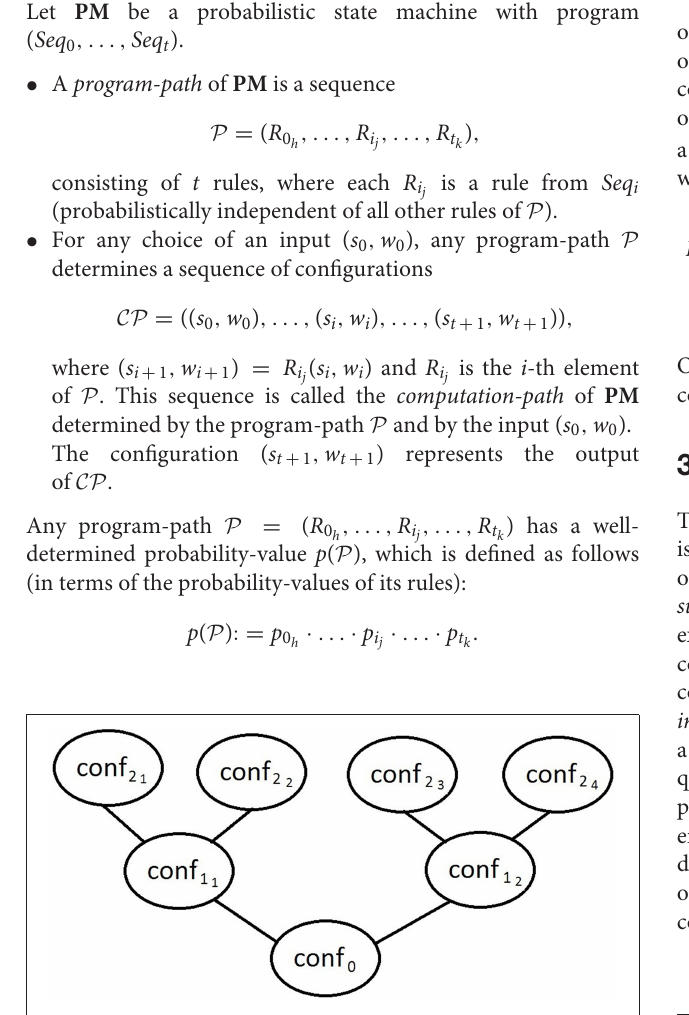
FIGURE 1 | The graph of PM